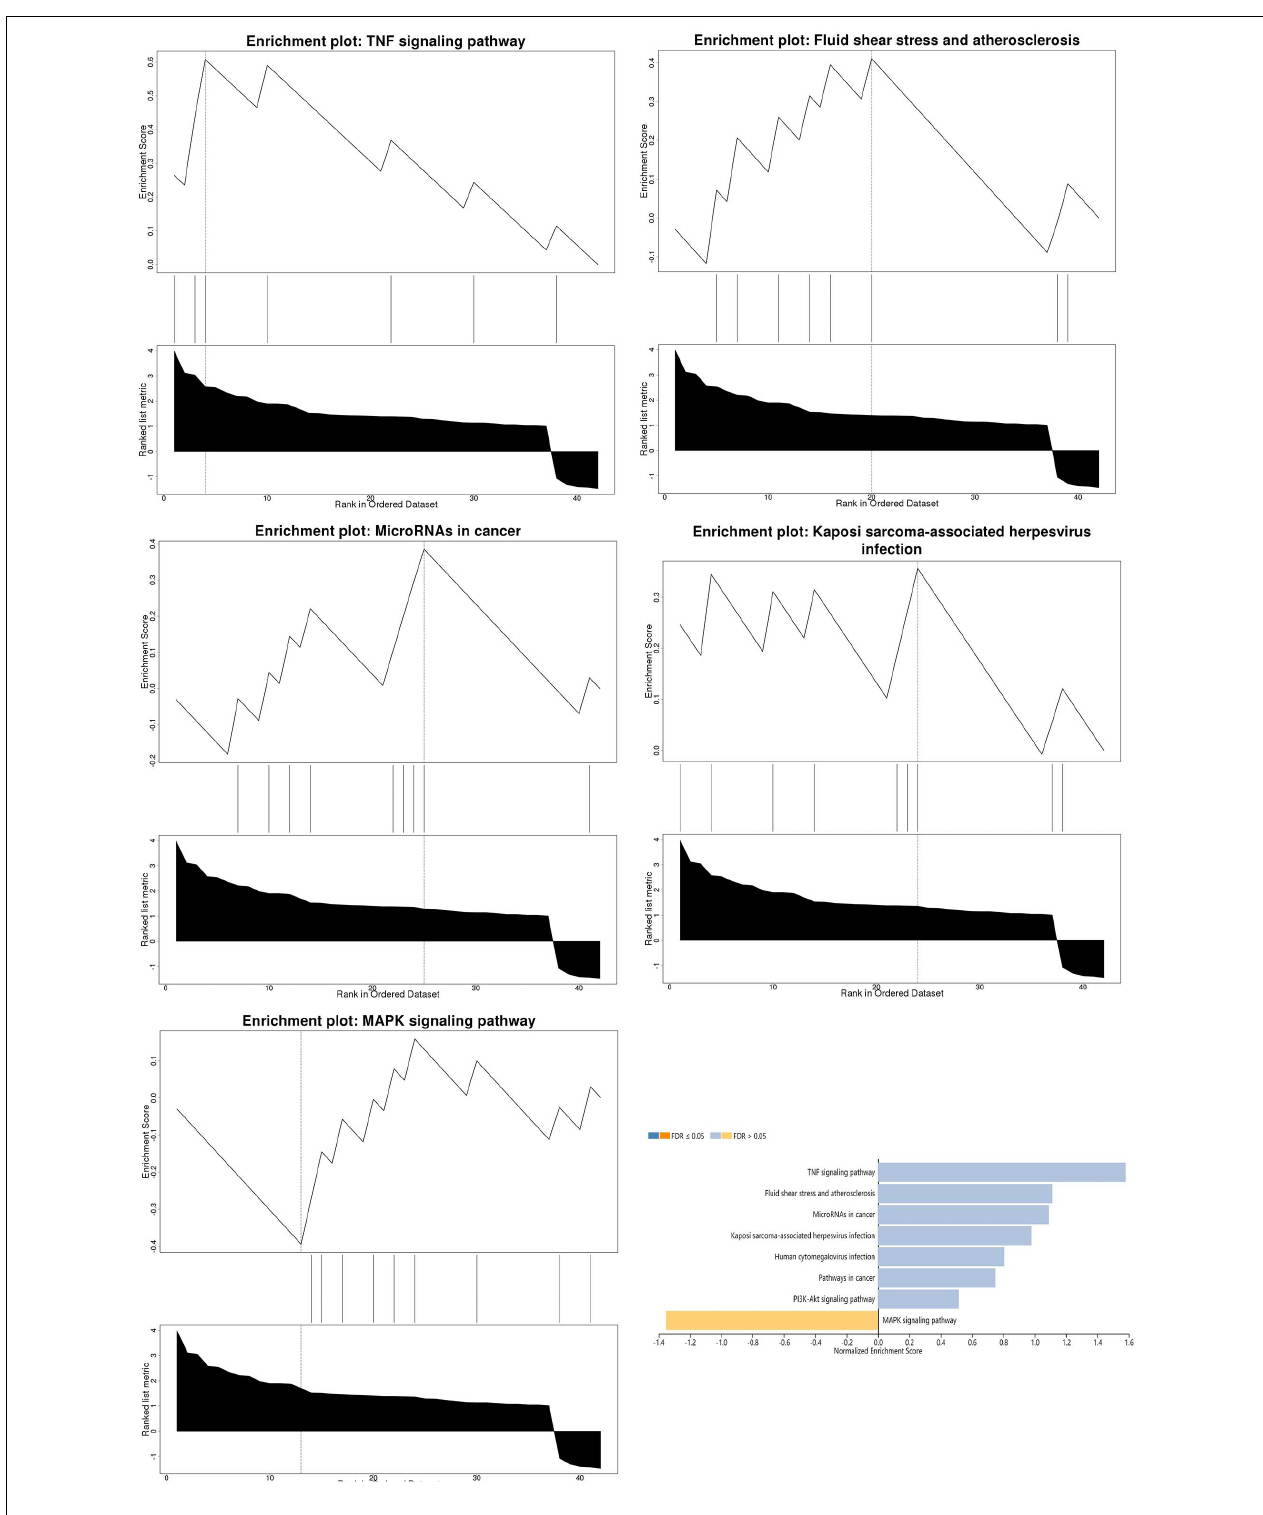
FIGURE 2 | The result of the enrichment gene dataset analysis indicated that the genes significantly enriched were involved in the TNF signaling pathway, MAPK signaling pathway, fluid shear stress, atherosclerosis, and Kaposi’s sarcoma-associated herpesvirus infection. Gene set enrichment analysis of WebGestalt first filtered the gene set according to the number of genes contained in the gene set, with a minimum number of seven genes and a maximum number of 2,000 genes by default.